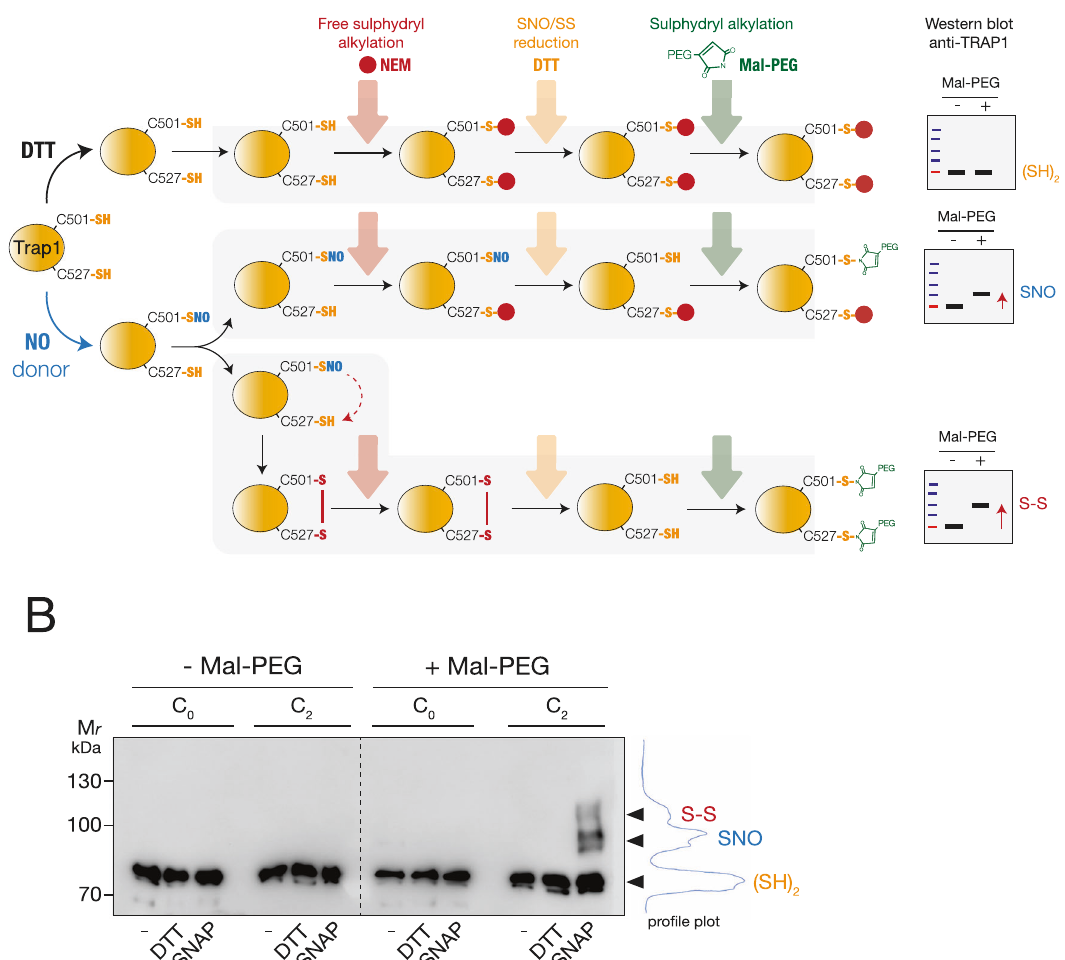
Fig. 4 Exposure to NO fl uxes results in the formation of a disul fi de bridge between C501 and C527 in human recombinant TRAP1. A Scheme of the protocol applied to detect cysteine redox modi fi cations in human recombinant TRAP1. C 2 -TRAP1 (which possesses only C501 and C527) has been treated in vitro with 500 μ M SNAP, or DTT (as control) for 4 h, at RT. Afterward, the excess of SNAP or DTT was washed out, and the protein was sequentially subjected to: i) thiol alkylation with N -ethylmaleimide (NEM) (red arrow), followed by ii) reduction with DTT (orange arrow) and iii) alkylation with Mal-PEG (green arrow), which confers an increase of the molecular weight proportional to the number of Mal-PEG bound. Depending on the C501 and C527 oxidation state [i.e., S -nitrosylated (SNO), or oxidized to disul fi de (S-S)], the sequence of reactions above described generates one or two immunoreactive bands upon Western blot analyses with an anti-TRAP1 antibody, which show apparent molecular weights higher than the fully reduced (SH) 2 or untreated protein. The same protocol was applied to C 0 (cysteine- free) mutant of TRAP1 as a negative control. B Western blot analyses of 1 µg of human recombinant C 0 and C 2 -TRAP1 mutants treated as described in A ). Fully reduced ((SH) 2 ), S -nitrosylated (SNO) or disul fi de-containing (S-S) variant of C 2 -TRAP1 are shown together with the pro fi le plot calculated with Fiji. Note that the molecular weight shift induced by the addition of one or more Mal-PEG moieties is not directly additive to the size of TRAP1. As reported in [104], this is due to drag and steric hindrance of branched proteins occurring during the migration through a gel compared to unlabelled linear proteins, which results in a shift which is usually greater than